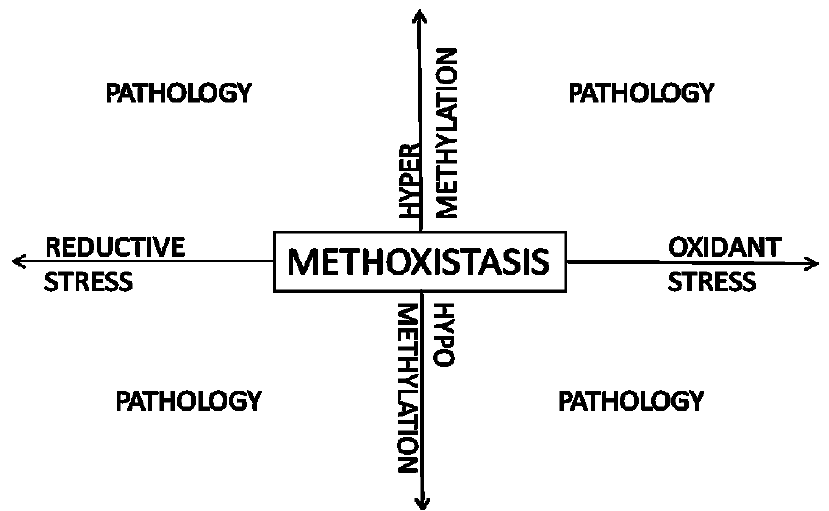
Figure 3. Methoxistasis: the close interrelationship between redox status and methylation balance is disturbed in pathologic